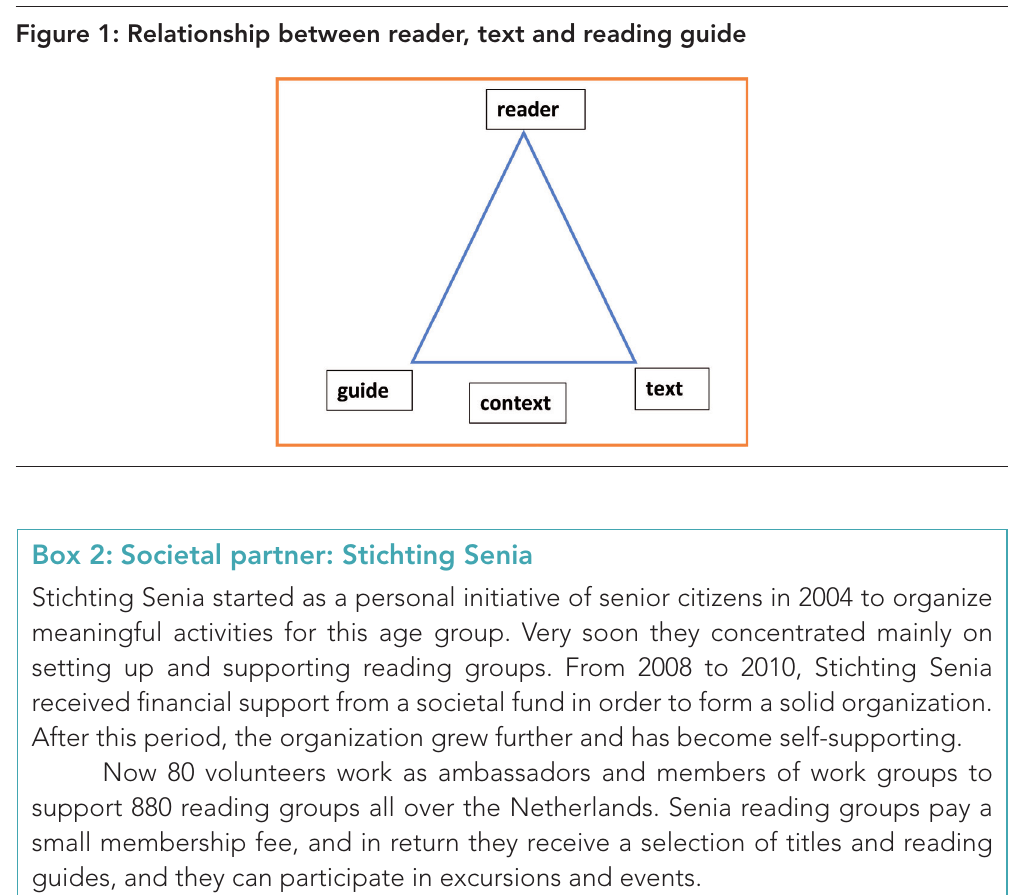
Figure 1: Relationship between reader, text and reading guide